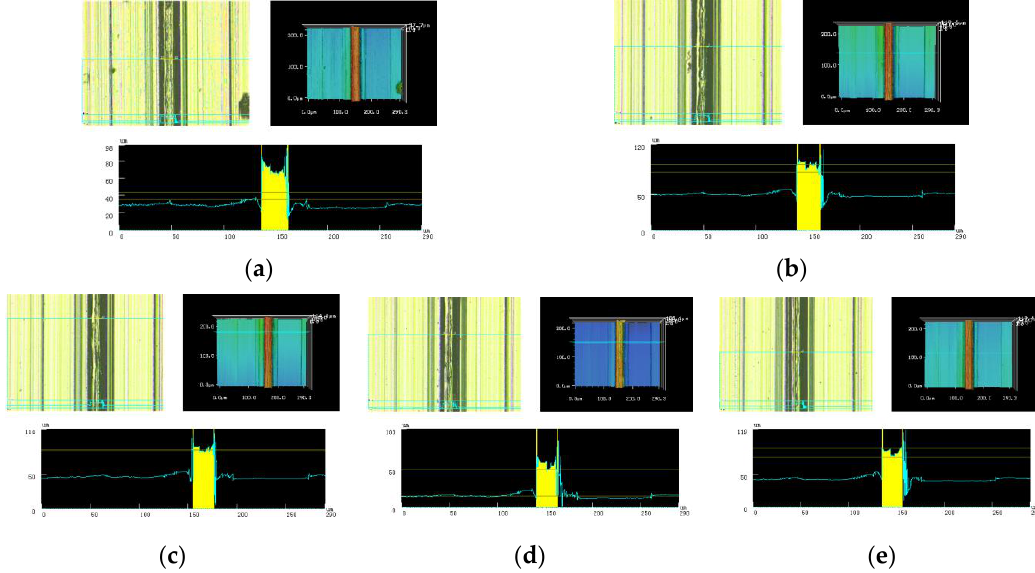
Figure 10. SEM photographs of microtextures at di ff erent rotation speeds: ( a ) 1000 r / min, ( b ) 1500 r / min, ( c ) 2000 r / min, ( d ) 2500 r / min, ( e ) 3000 r /